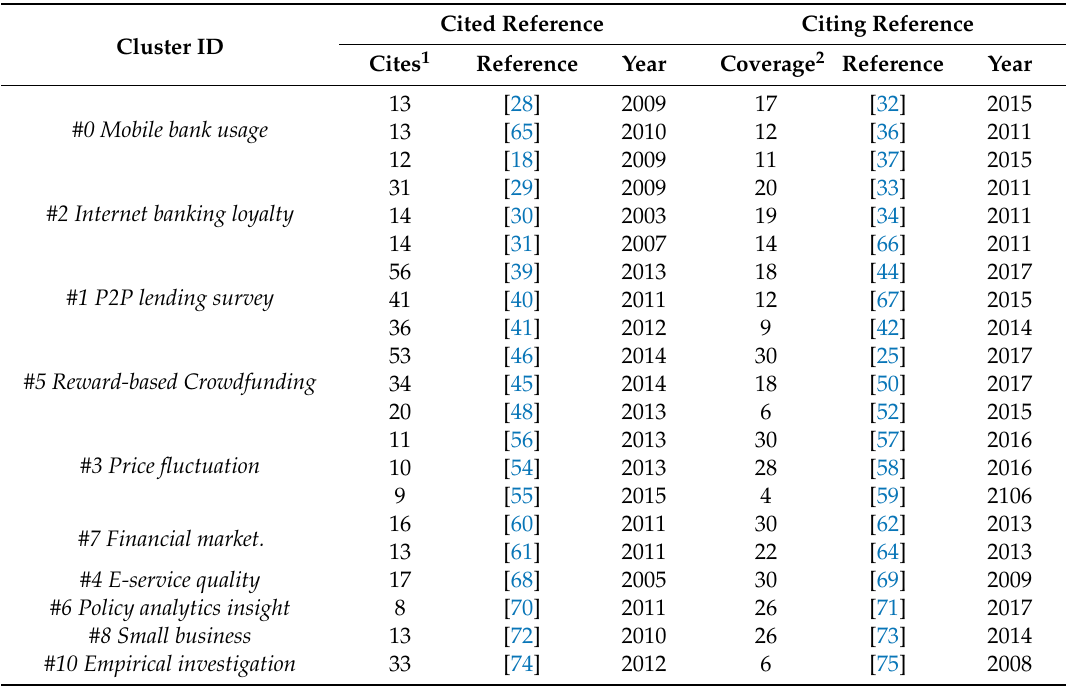
Table 4. Main works of each